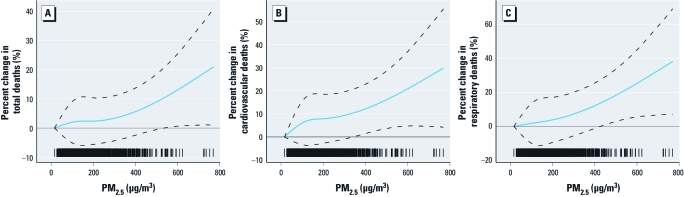
Exposure–response relationships (smoothing plots) of PM2.5 against total (A), cardiovascular (B), and respiratory (C) mortality (df= 3) in Xi’an, adjusted for temporal trend, day of the week, temperature, relative humidity, and SO2 and NO2 concentrations. The x-axis is the PM2.5 concentrations (single day lag, L1); the y-axis is the estimated percent change in deaths; the solid blue lines indicate the estimated mean percent change in daily death numbers using the lowest PM2.5 concentration as the reference level; and the dashed lines represent the 95% CI.